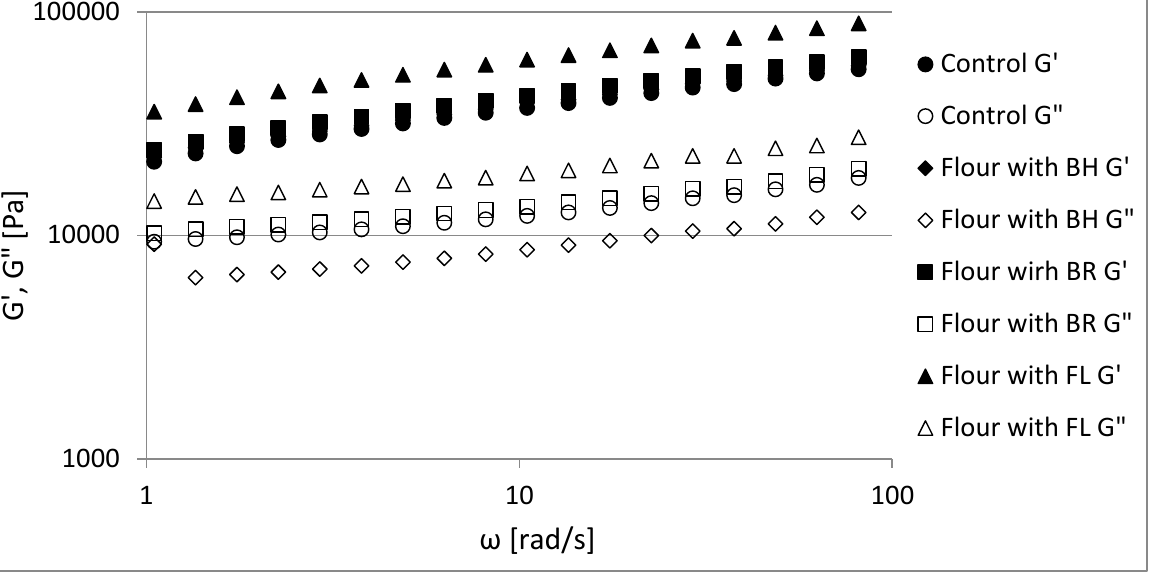
Figure 1. Mechanical spectra of dough samples for flour (control), flour with buckwheat (BH), beetroot (BR) and flax (FL).